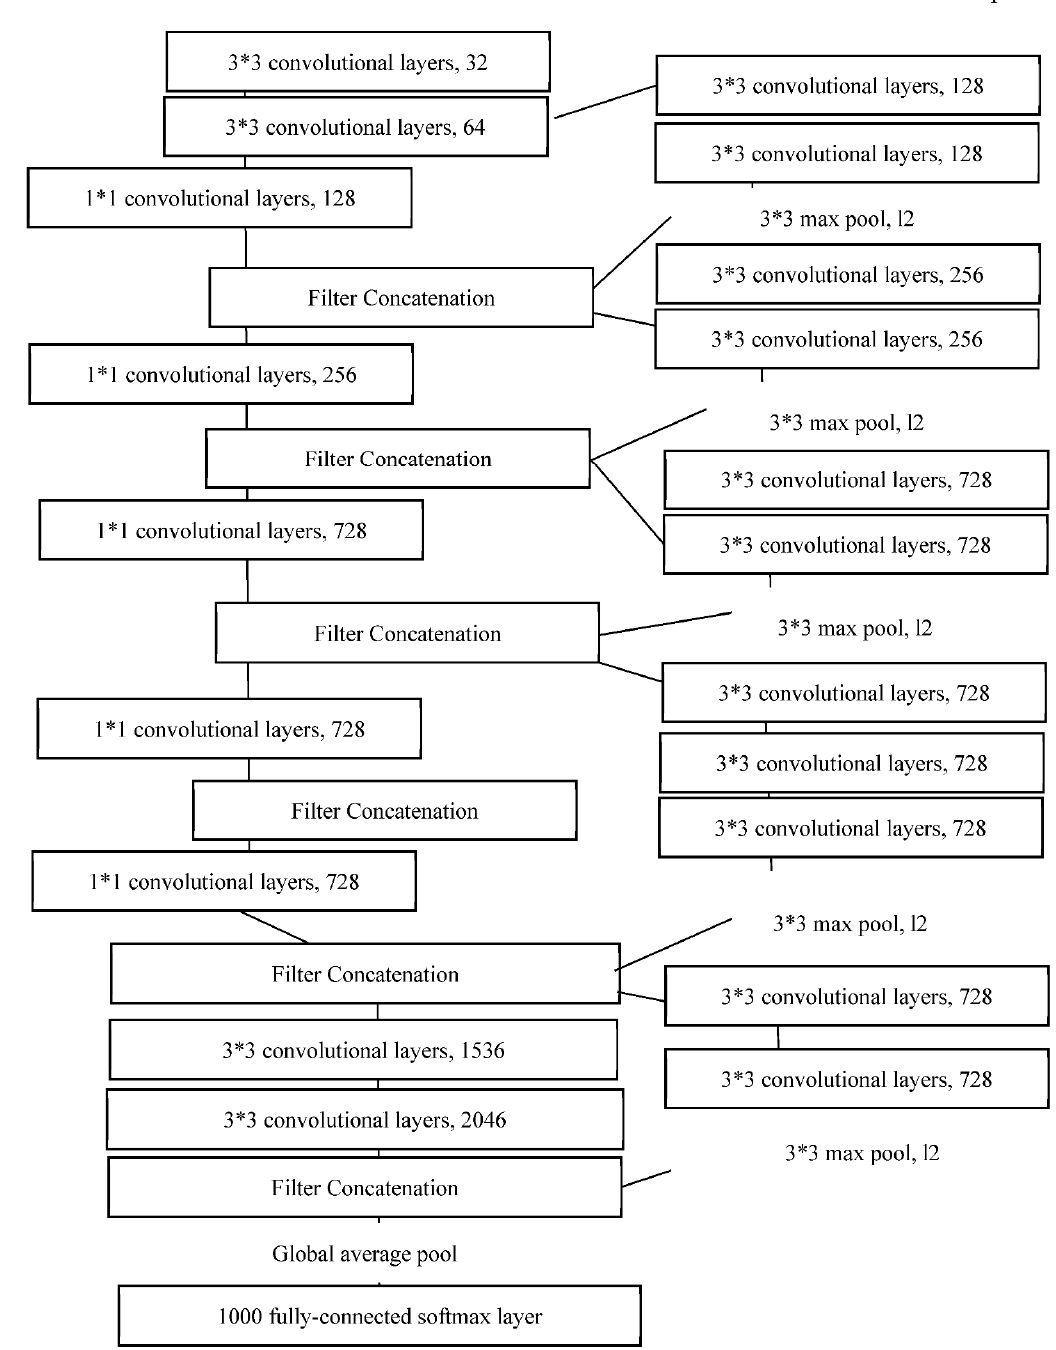
Figure 6. The Xception architecture.